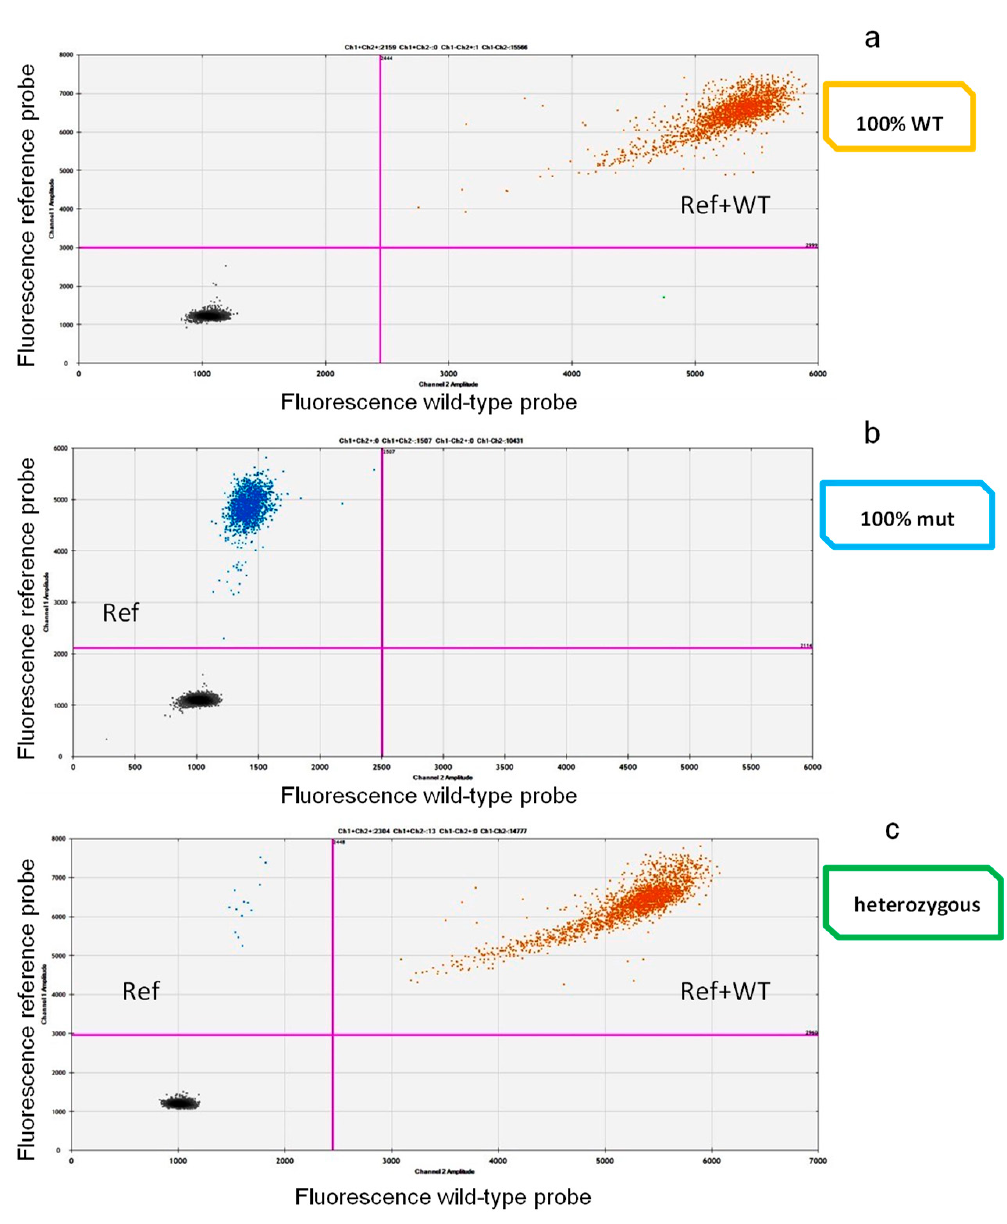
Figure 6. Two-dimensional (2D)-plot drop-o ff ddPCR. In the 2D plot, samples with di ff erent IDH2 genotypes are represented, with channel 1 fluorescence (reference probe) plotted against channel 2 fluorescence (WT probe). The droplets are arranged according to the fluorescence levels. In ( a ), a wild-type (WT) sample represented by a “double positive” population (in orange; reference and wild-type probe in the same droplet) (ref + wt). In ( b ), a 100% IDH2-mutated case, where only the reference probe (blue = ref) matched with the IDH2 sequence. In ( c ), a sample carrying the mutation in heterozygosity. This panel represents two droplets’ populations, the (with few events) mutated one (blue) (ref) and the (with a higher number of events) double positive (orange) (ref + wt) one. The ddPCR was performed using the QX200 platform (BioRad R, Hercules, CA, USA), consisting of two instruments: The droplet generator and the droplet reader. The droplet generator divides the sample by creating about 20,000 partitions (droplets). The droplets are then transferred into PCR plates and, at the end of the amplification cycles, placed into the droplet reader. Here, each droplet is detected as mutated or wild-type by issuing specific fluorescence signals (FAM for the mutation and Table 7. Drop off ddPCR primers and probes sequences.